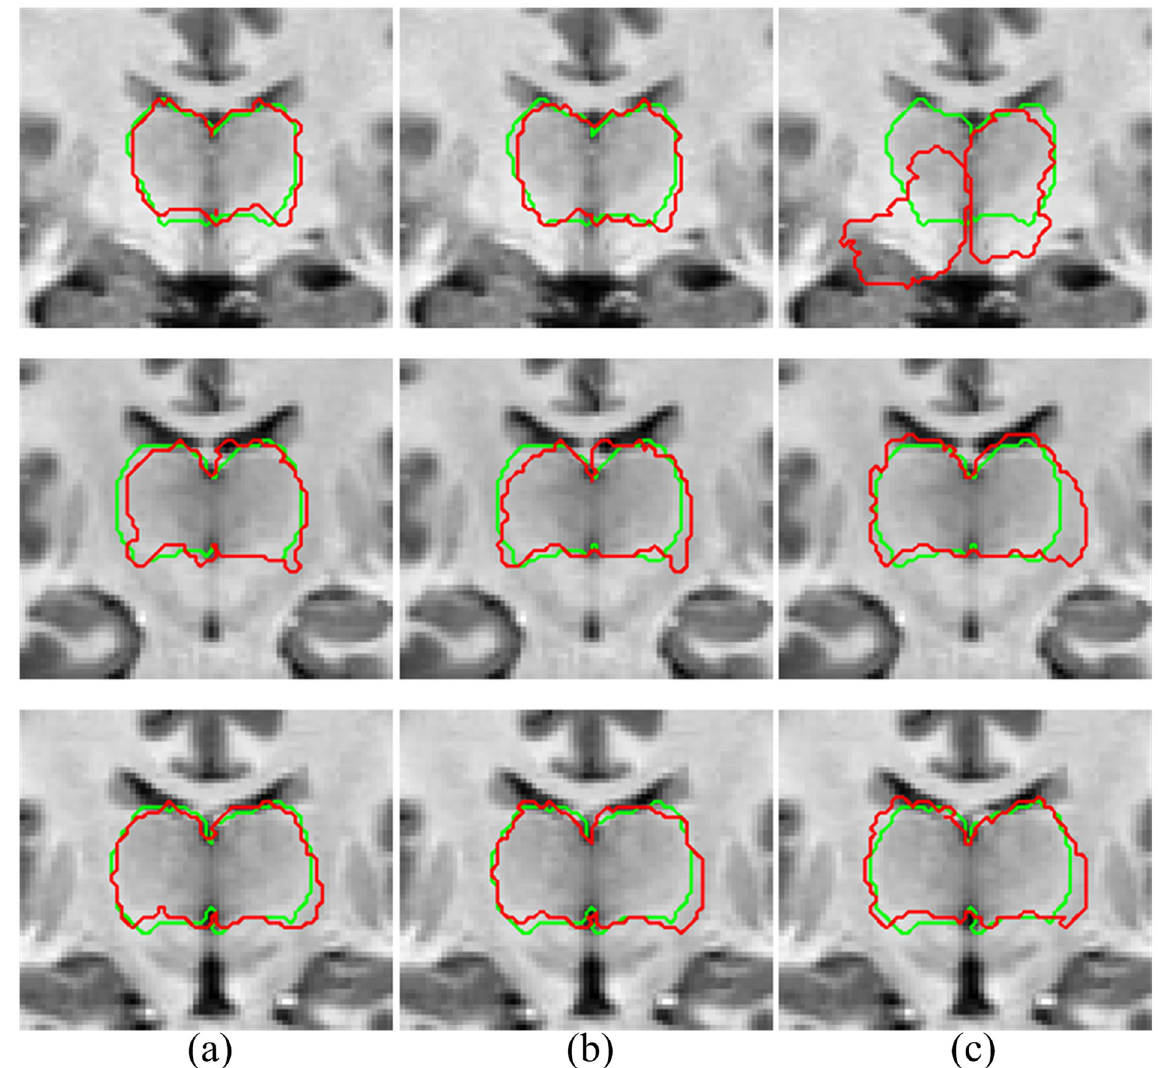
Figure 3. Registration performance comparison between ANTS, DRAMMS and Demons. ( a ) ANTS, ( b ) DRAMMS, ( c ) Demons. Each row represents different patient. The red contours in each column represent the warped thalamus boundary after ANTS, DRAMMS and Demons registration, respectively. The green contours are the ground truth that manually delineated by